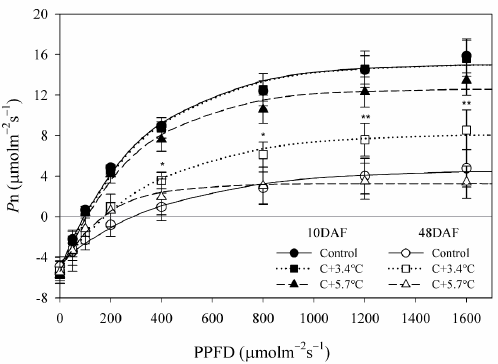
Figure 3. Light-curve of peach trees grown under different temperatures and a carbon dioxide concentration of 700 μ mol·mol − 1 on 20 May (10 DAF) and 27 June (48 DAF). The solid circle, square and triangle represent control, C+3.4 °C and C+5.7 °C respectively. Vertical bars represent the standard error of means from five replications. The asterisks * and ** indicate significant differences at p ≤ 0.05 and p ≤ 0.01, respectively.